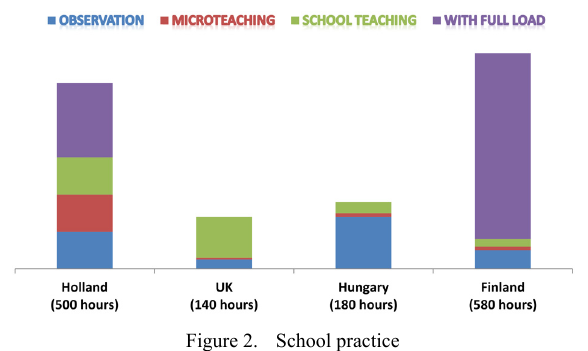
Figure 2. School